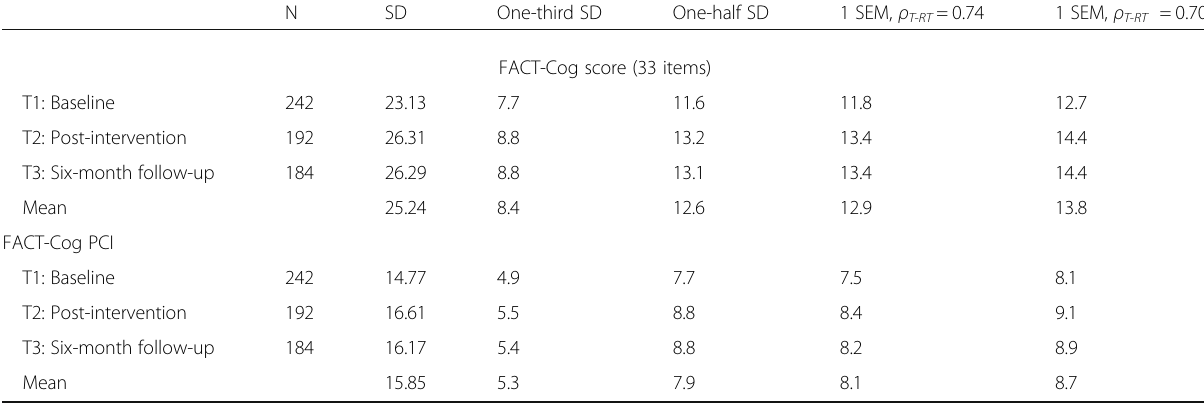
Table 4 Distribution-based CID (SD multiples) and MCT lower limit (SEM) estimates for the FACT-Cog total score and perceived cognitive impairments